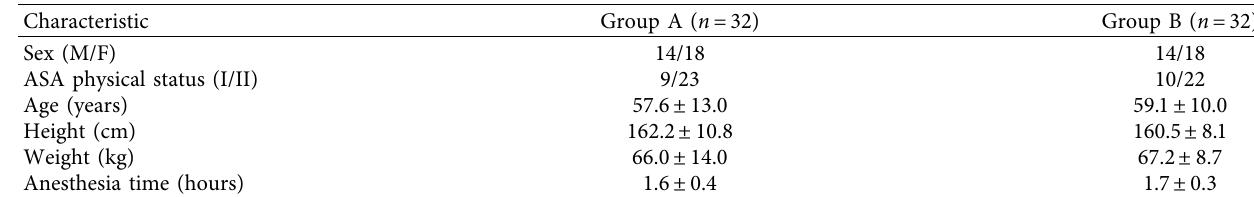
Figure 1: Patient enrollment and a study fowchart. Table 1: Demographic data.